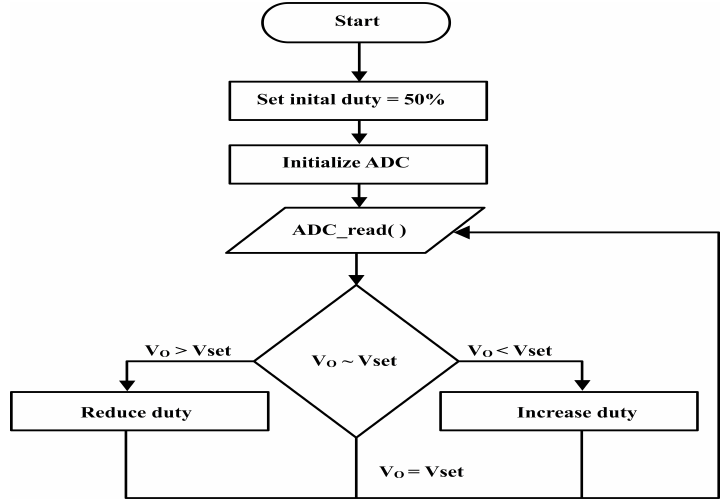
Figure 5. Flowchart of the closed-loop PI control scheme. Table 1. Prototype